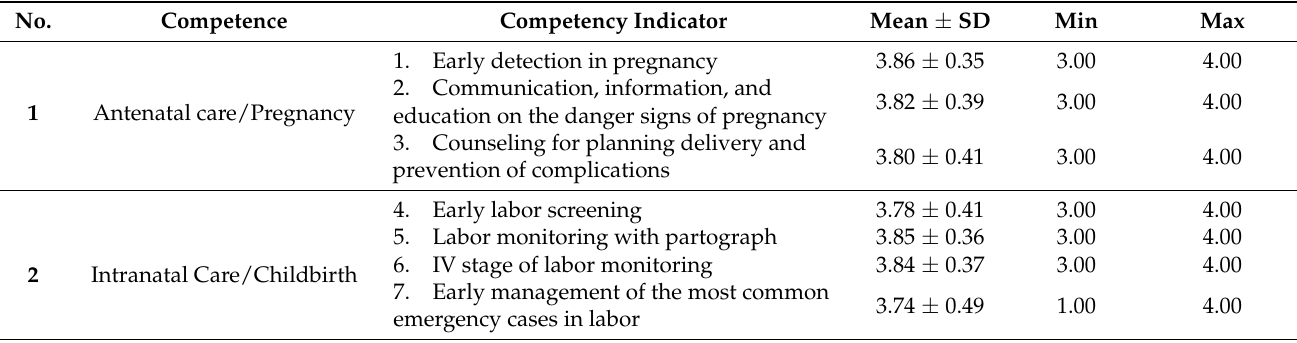
Table 3. The survey’s results on the continuity of midwifery care competency